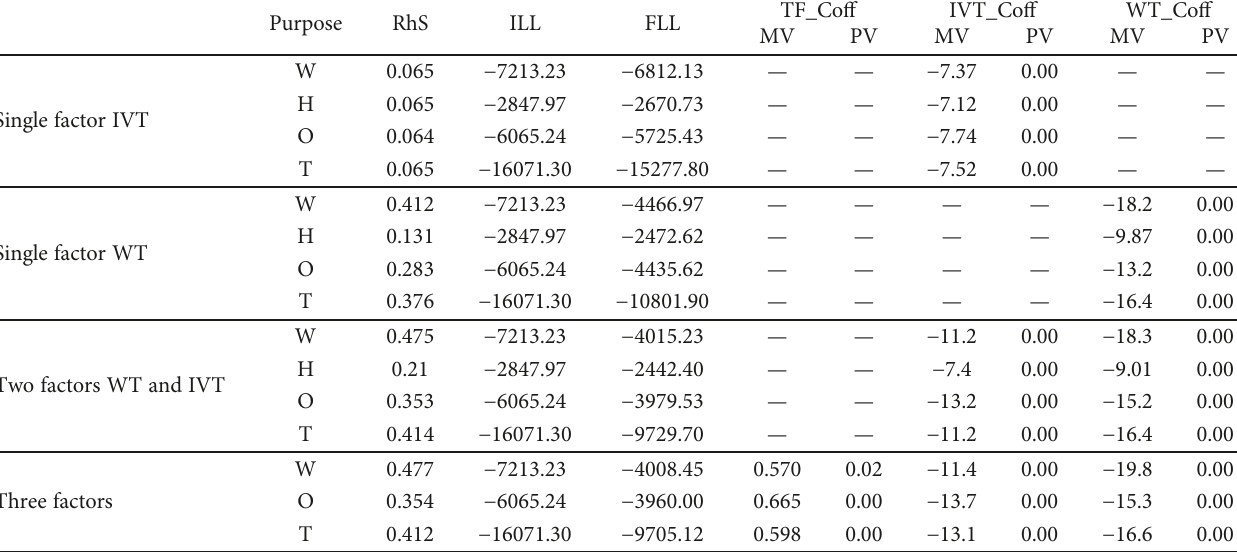
Table 3: Results of the di ff erent factor combination of the MNL model.